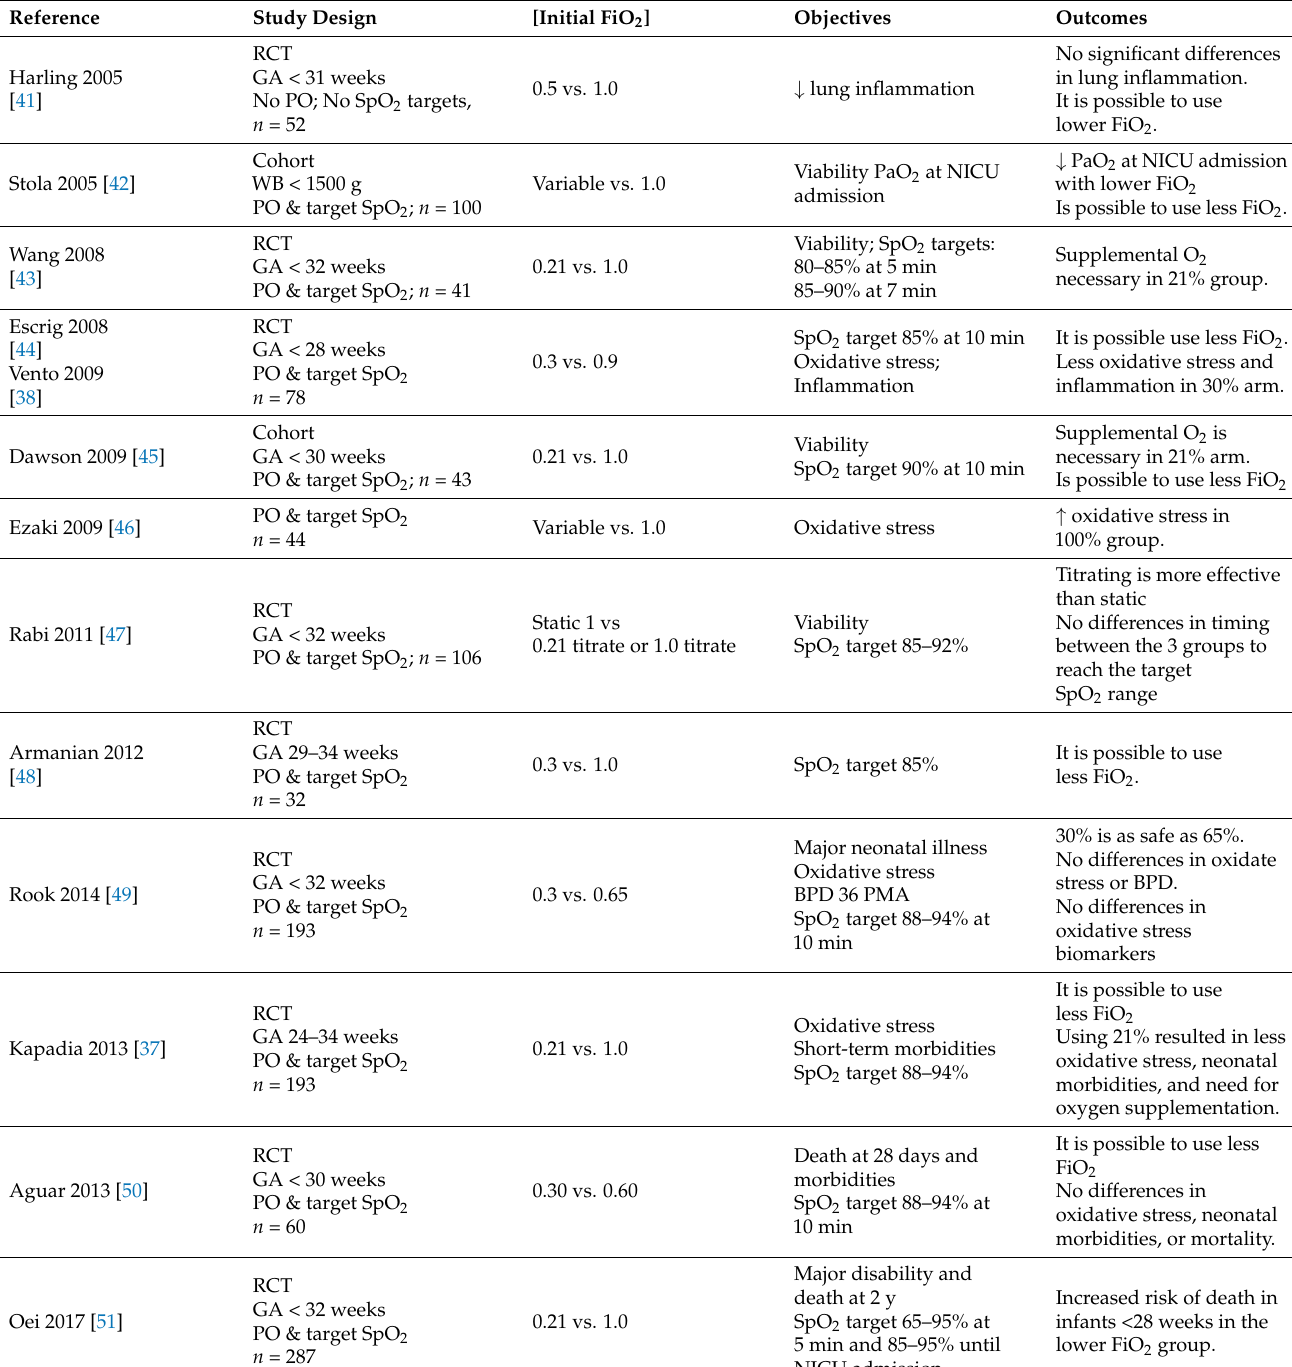
Table 1. Clinical studies comparing higher or lower initial FiO 2 for the stabilization of preterm infants in the delivery